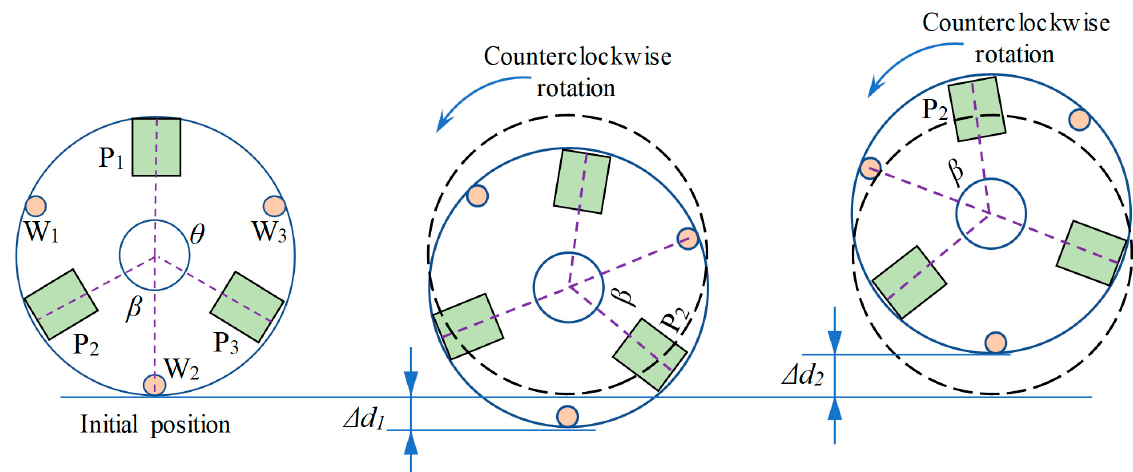
Figure 10. Diagram of the rotating eccentricity of the coreless motor winding.